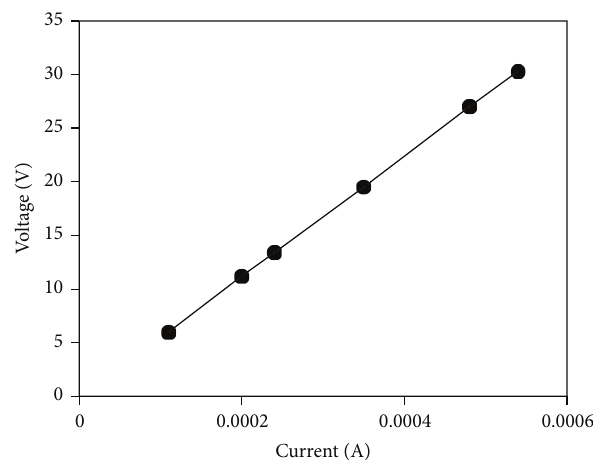
Figure 12: Compressive strength of